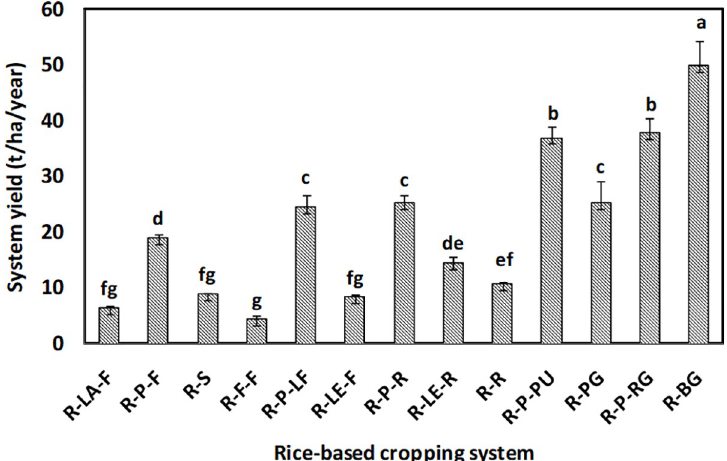
Fig 2. System yield (t − 1 ha) based on rice-equivalent yield of dry season crops. [R-LA-F: rice-lathyrus-fallow, R-P-F: rice-potato-fallow, R-S: rice-sunflower, R-F-F: rice-fallow-fallow, R-P-LF: rice-potato-ladies finger, R-LE-F: rice-lentil- fallow, R-P-R: rice-potato-rice, R-LE-R: rice-lentil-rice, R-R: rice-rice, R-P-PU: rice-potato-pumpkin, R-PG: rice- pointed gourd, R-P-RG: rice-potato-ridge gourd, R-BG: rice-bitter gourd]; means followed by same letters are statistically at par (otherwise significantly different at p < 0.05) by Tukey’s Honest Significant Difference (HSD) test. The standard error of means has been given as error bars. The description of the said post-hoc test also applies to Figs 3, 4, 6, 7, 8, and